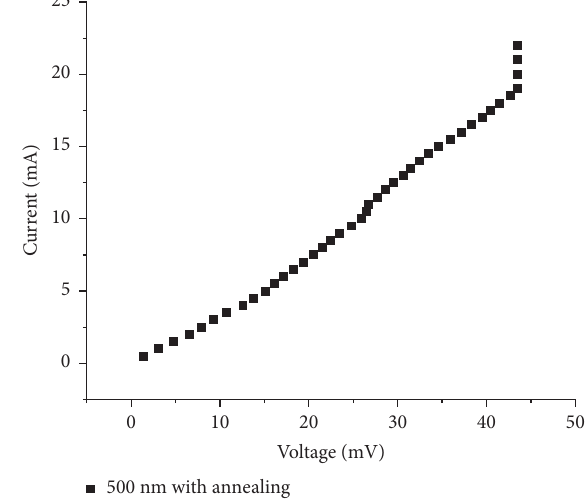
Figure 2: Dependence of voltage on current for a sample subjected to annealing at 100 ∘